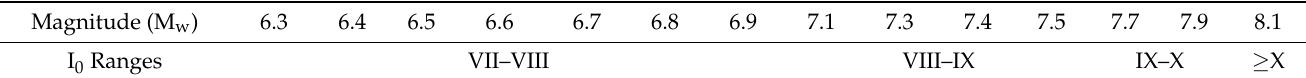
Table 4: Table 4. Conversion of the magnitude into intensity I 0